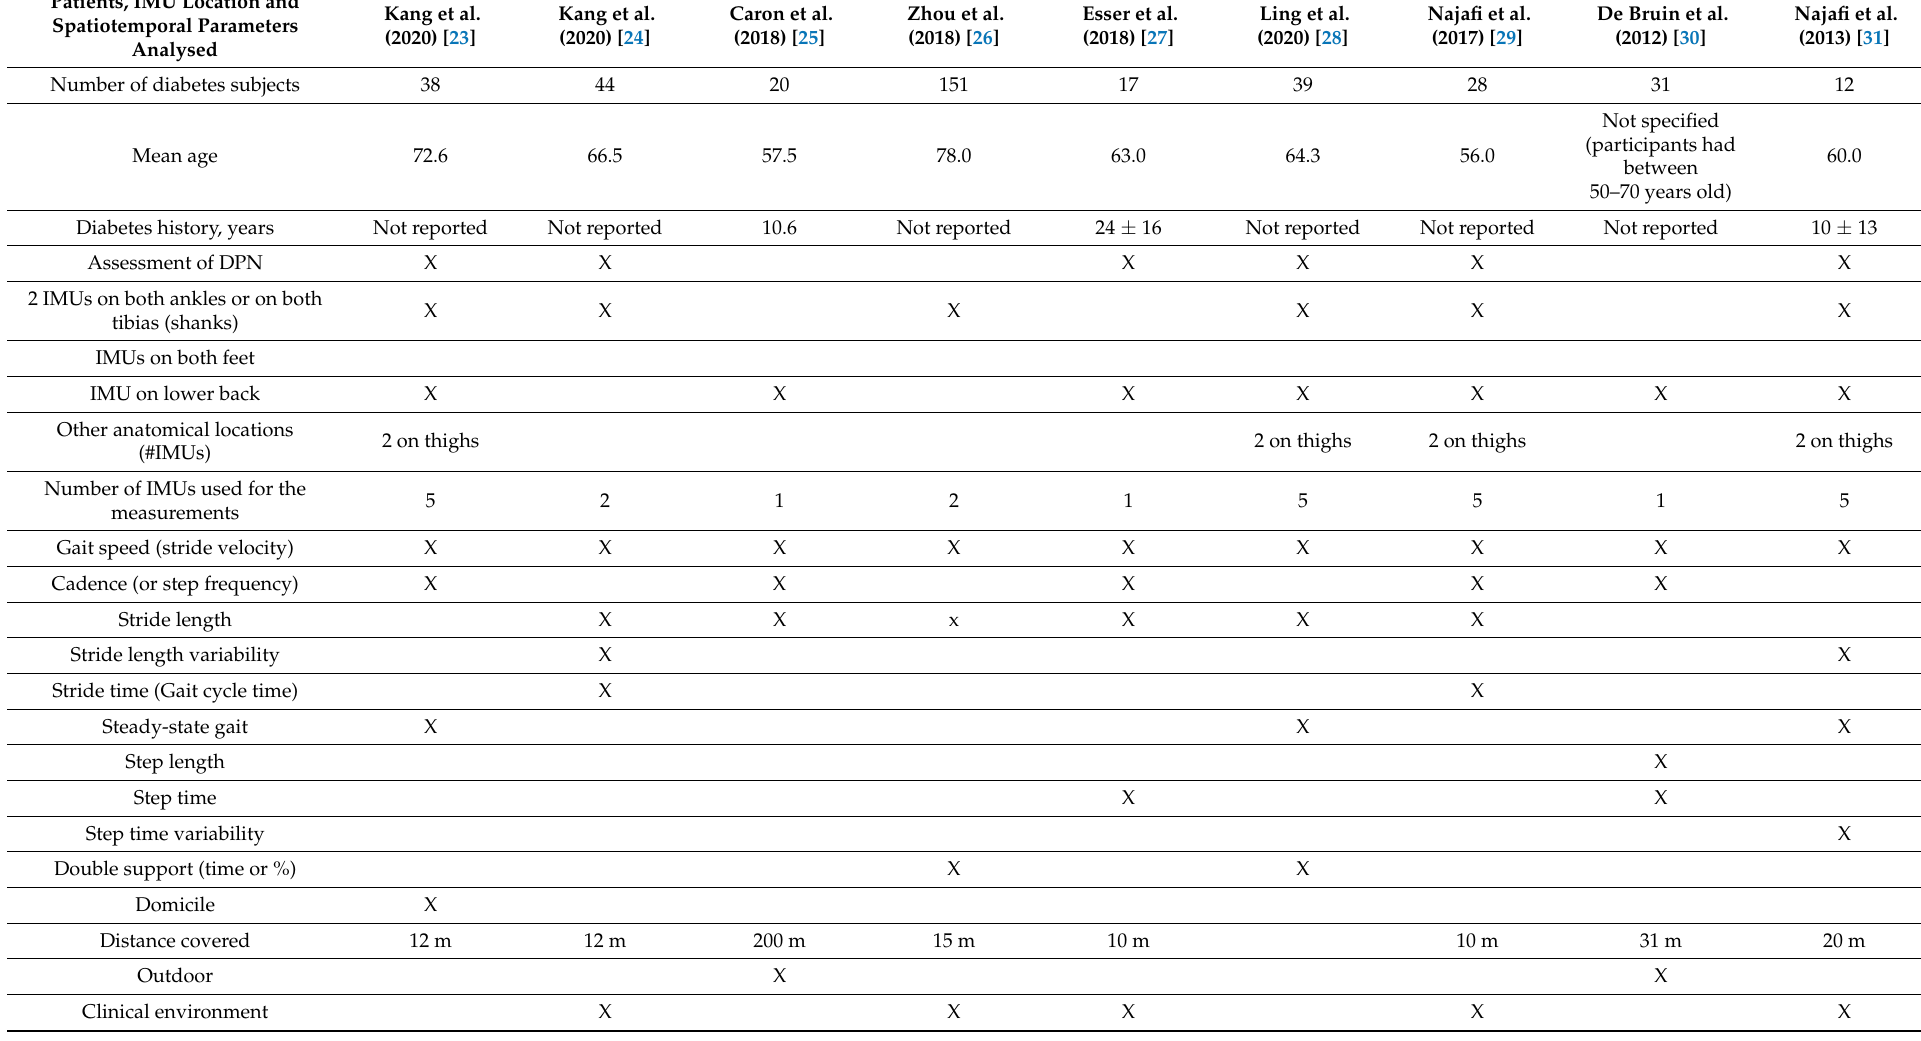
Table 1. Characteristics of wearable sensors and spatiotemporal parameters. X: item assessed in the